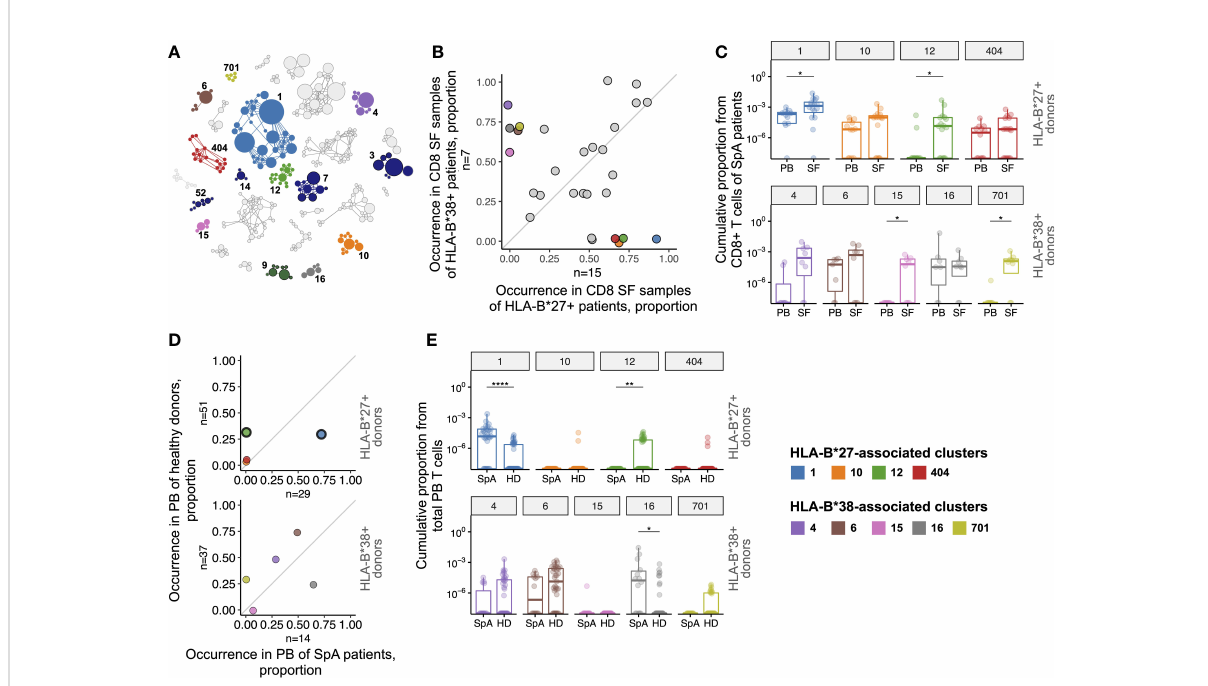
FIGURE 2 T cell clonotypes involved in immune response in synovial fl uid of SpA patients. (A) , Similarity network of SF CD8+ clonotypes identi fi ed by the ALICE. Only 29 clusters shared by ≥ 3 patients are shown. Each node represents a unique amino acid clonotype. Edges connect clonotypes differing in one CDR3 amino acid residue. Node ’ s size corresponds to the number of donors sharing this clonotype. Color highlights clusters associated with HLA-B*27, HLA-B*38, or found in VDJdb. (B) , Occurrence of the clusters in CD8+ SF samples of HLA-B*27+ (n=15) vs HLA-B*38+ (n=7) patients. (C) , T cell frequency of HLA-B*27-associated (upper, n(PB)=12, n(SF)=16) or HLA-B*38-associated (bottom, n(PB)=7, n(SF)=8) clusters in CD8+ repertoires of patients. Occurrence (D) and T cell frequency (E) of HLA-B*27-associated (upper, n(SpA)=29, n(HD)=51) or HLA-B*38-associated (bottom, n(SpA)=14, n(HD)=37) clusters in total PB repertoires of SpA patients and HD. Black circles mark clusters signi fi cantly enriched by Fisher ’ s exact test with Benjamini-Hochberg adjusted p<0.05. On the box plots the middle line corresponds to the median, the lower and upper hinges correspond to the 25th and 75th percentiles, respectively. The upper and lower whiskers extends from the hinges to the largest and smallest values no further than 1.5 * IQR from the corresponding hinge. Each dot represents an individual sample. For patients with relapses only repertoires of time point 1 were included in the analysis. PB - peripheral blood, SF - synovial fl uid, SpA - spondyloarthritis, HD - healthy donors. Wilcoxon rank sum test with Benjamini-Hochberg adjustment *p < 0.05, **p < 0.01, ****p <